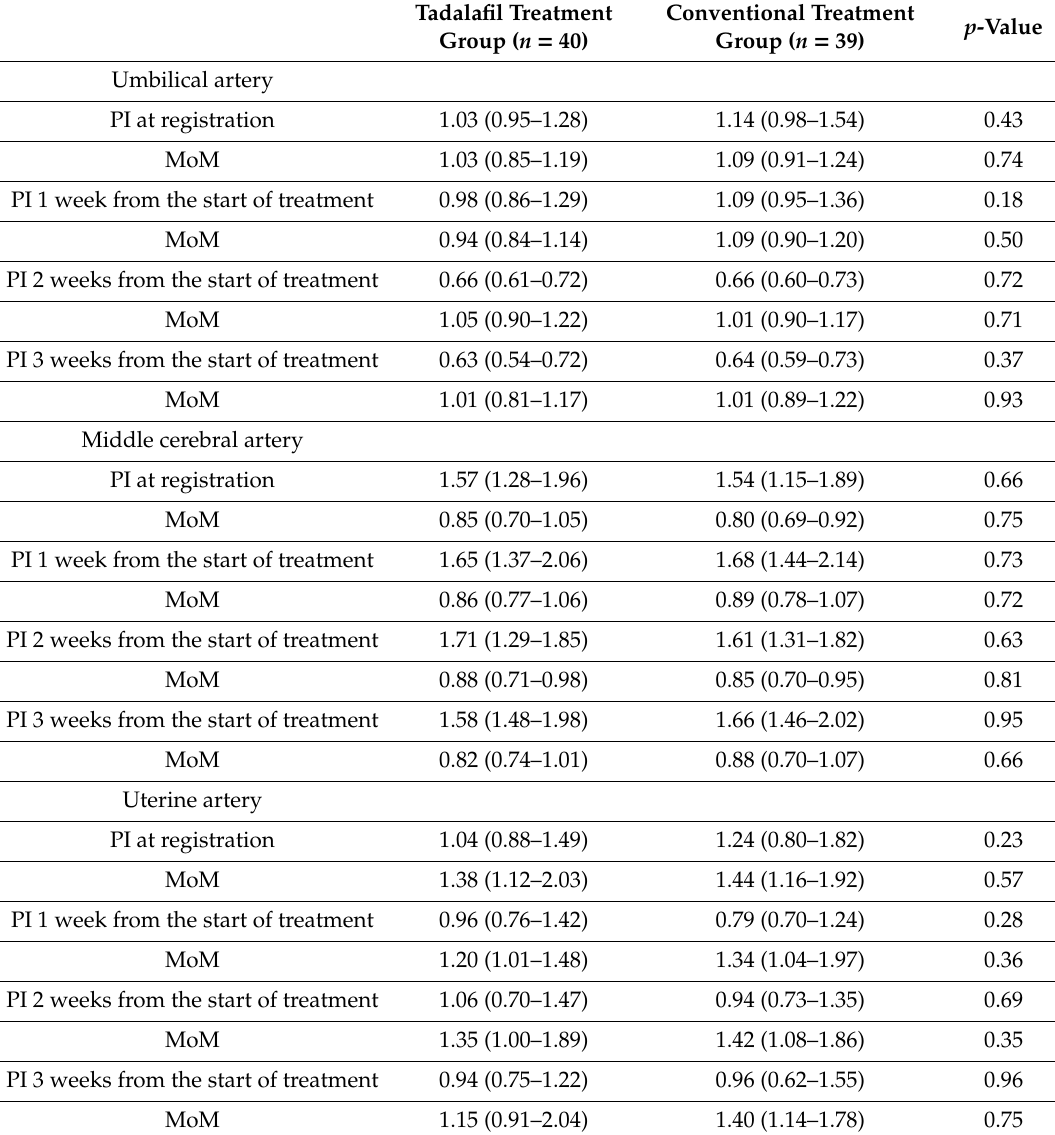
Table 9. Doppler study analysis of maternal or fetal